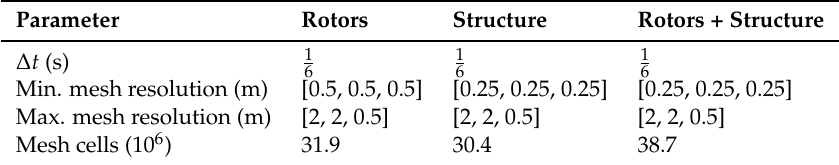
Table 2. Simulation configuration